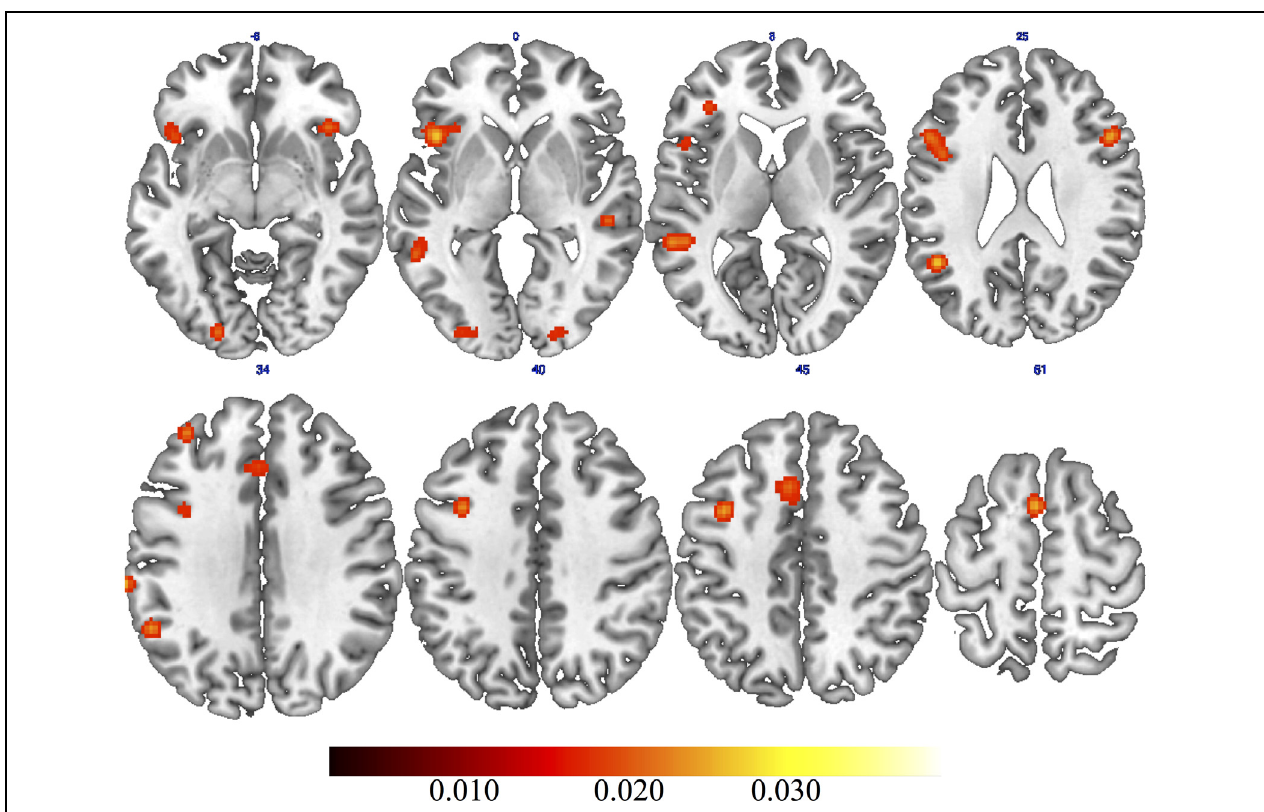
FIGURE 1 | Results of general activation likelihood estimation (ALE) meta-analysis on